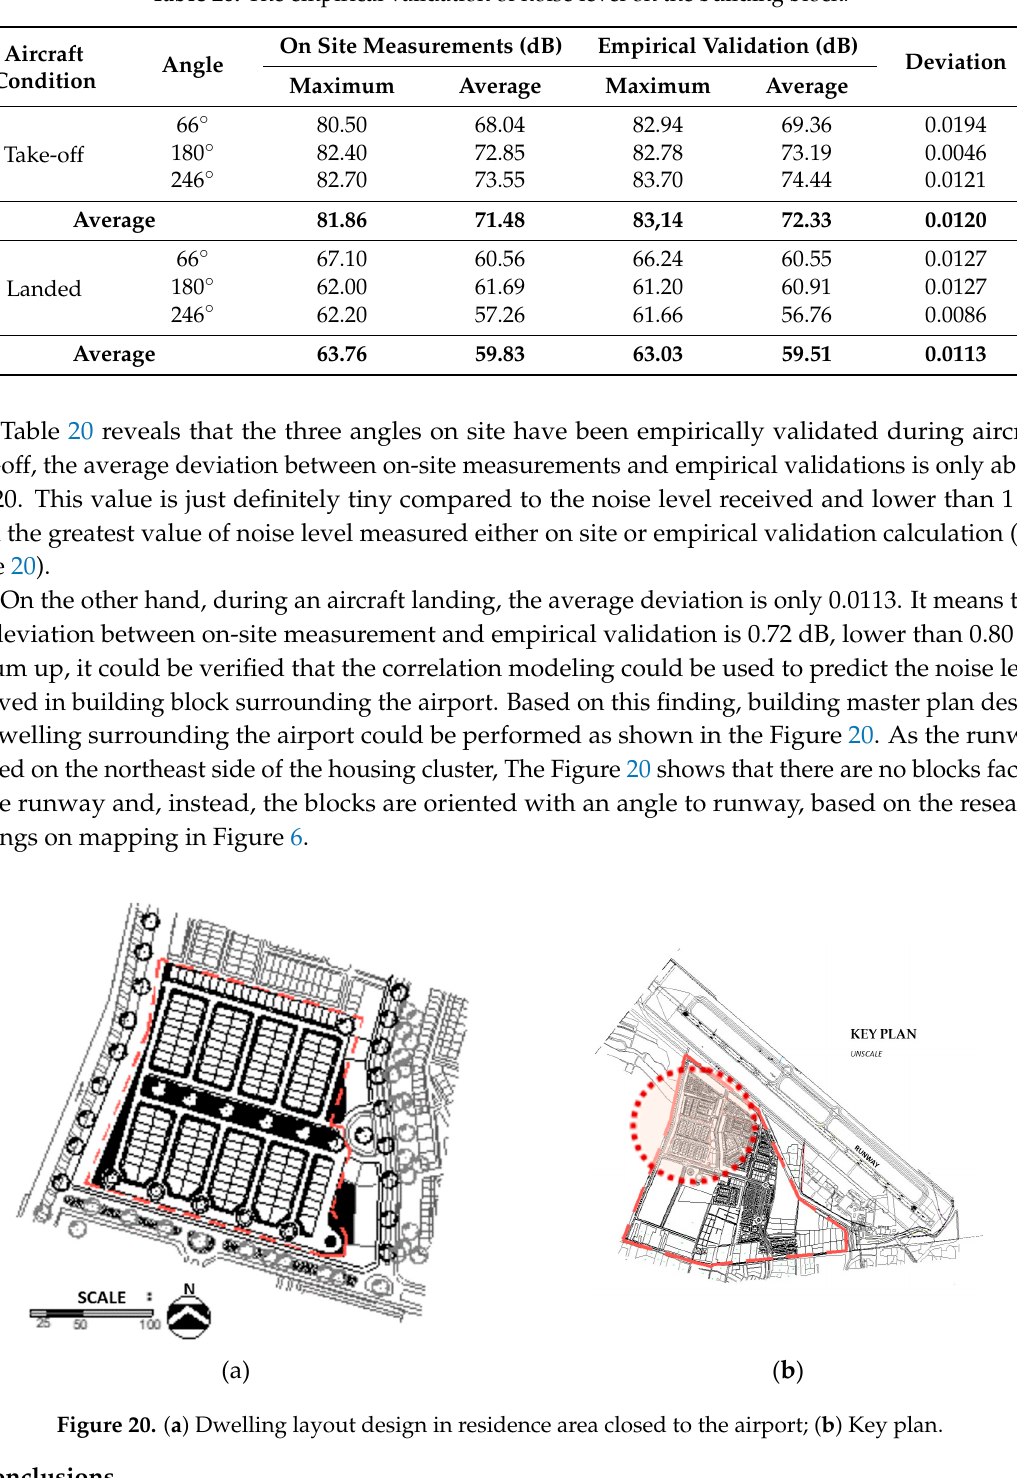
Table 20. The empirical validation of noise level on the building block.